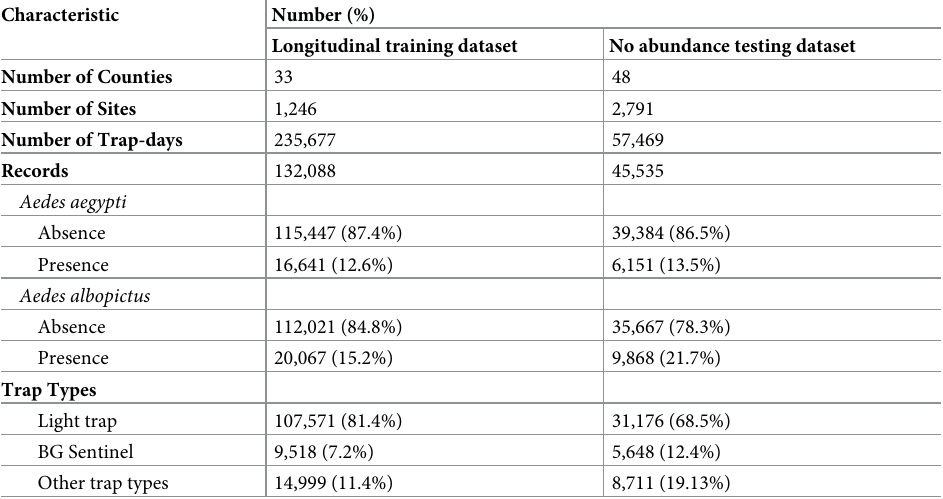
Table 1. Characteristics of surveillance of Aedes aegypti and Aedes albopictus in Florida, 2004–2018.